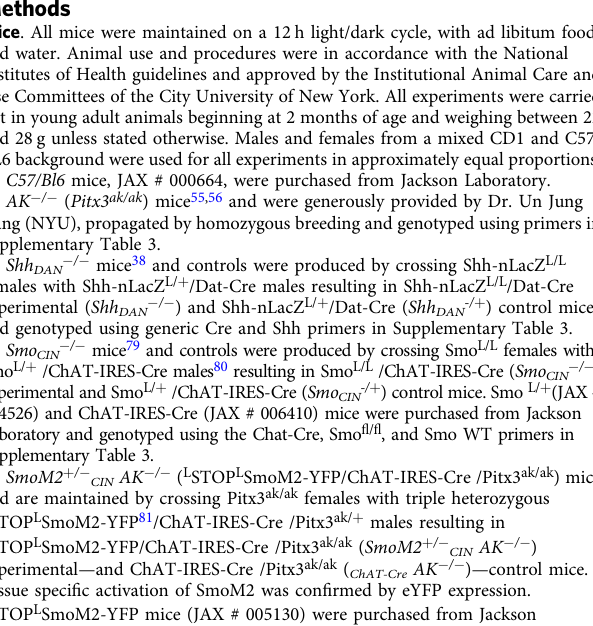
Supplementary Table 3. Shh DAN − / − mice 38 and controls were produced by crossing Shh-nLacZ L/L females with Shh-nLacZ L/ + /Dat-Cre males resulting in Shh-nLacZ L/L /Dat-Cre experimental ( Shh DAN − / − ) and Shh-nLacZ L/ + /Dat-Cre ( Shh DAN -/ + ) control mice and genotyped using generic Cre and Shh primers in Supplementary Table 3. Smo CIN − / − mice 79 and controls were produced by crossing Smo L/L females with Smo L/ + /ChAT-IRES-Cre males 80 resulting in Smo L/L /ChAT-IRES-Cre ( Smo CIN − / − ) experimental and Smo L/ + /ChAT-IRES-Cre ( Smo CIN -/ + ) control mice. Smo L/ + (JAX # 004526) and ChAT-IRES-Cre (JAX # 006410) mice were purchased from Jackson Laboratory and genotyped using the Chat-Cre, Smo fl / fl , and Smo WT primers in Supplementary Table 3. SmoM2 + / − CIN AK − / − ( L STOP L SmoM2-YFP/ChAT-IRES-Cre /Pitx3 ak/ak ) mice and are maintained by crossing Pitx3 ak/ak females with triple heterozygous L STOP L SmoM2-YFP 81 /ChAT-IRES-Cre /Pitx3 ak/ + males resulting in − / − ) L STOP L SmoM2-YFP/ChAT-IRES-Cre /Pitx3 ak/ak ( SmoM2 + / − CIN AK experimental — and ChAT-IRES-Cre /Pitx3 ak/ak ( ChAT-Cre AK − / − ) — control mice. Tissue speci fi c activation of SmoM2 was con fi rmed by eYFP expression. L STOP L SmoM2-YFP mice (JAX # 005130) were purchased from Jackson Laboratory and genotyped using the ChAT-Cre, SmoM2 mutant, and SmoM2 WT primers in Supplementary Table 3.